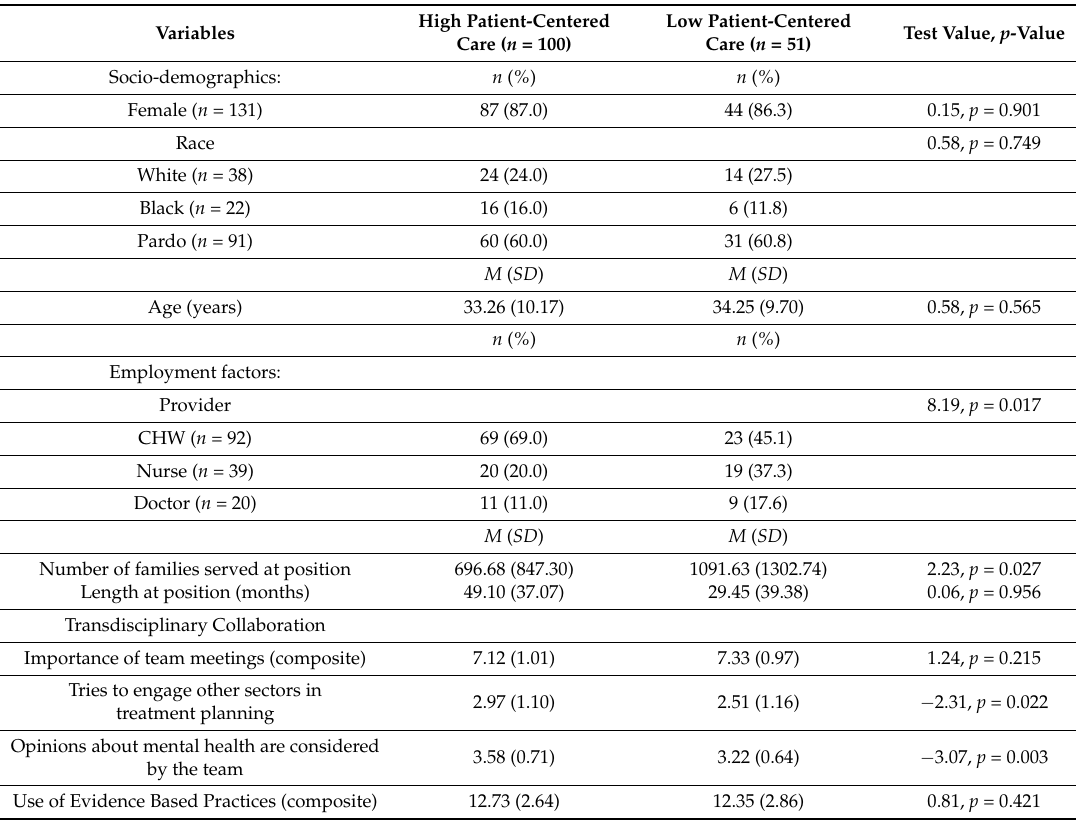
Table 1. Predictors associated with providers’ perceptions of patient-centered mental health care provision ( n =